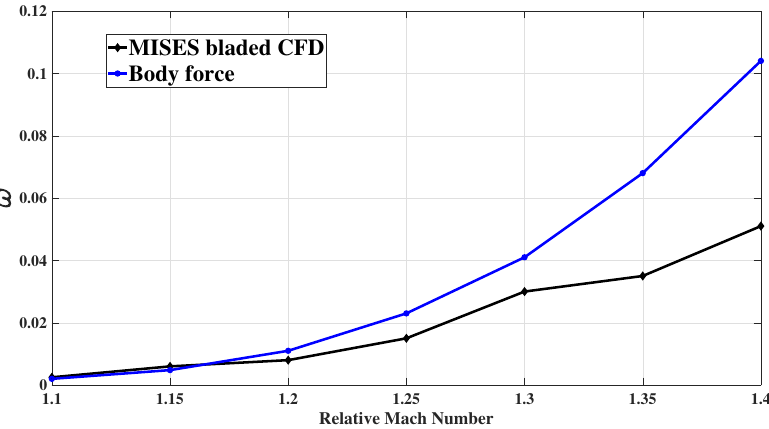
Figure 12. Assessment of shock loss for cascade